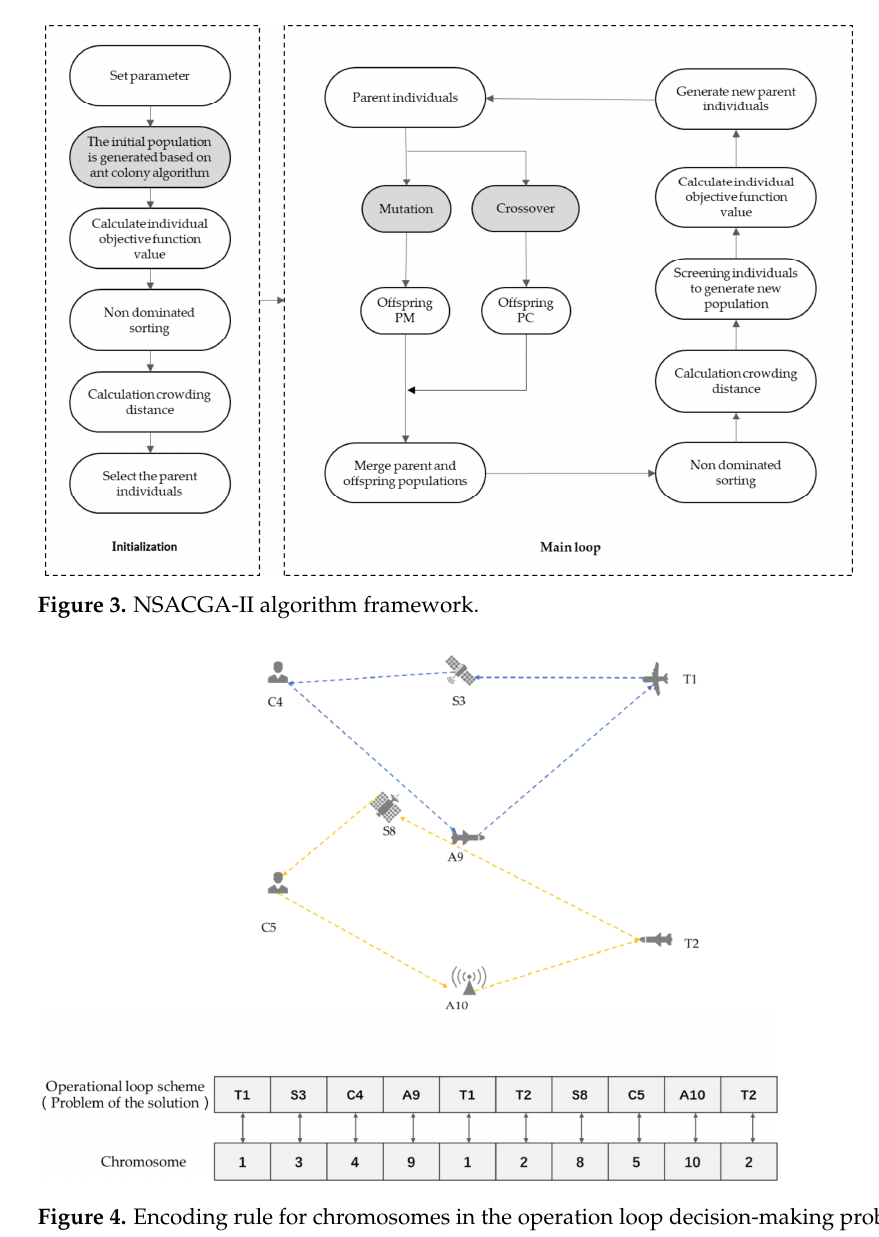
Figure 4. Encoding rule for chromosomes in the operation loop decision-making problem.